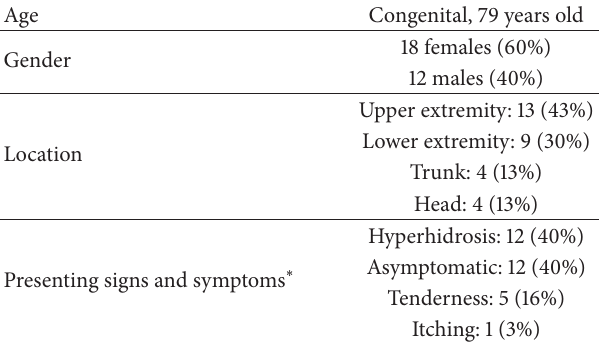
Figure 1: Preoperation picture.